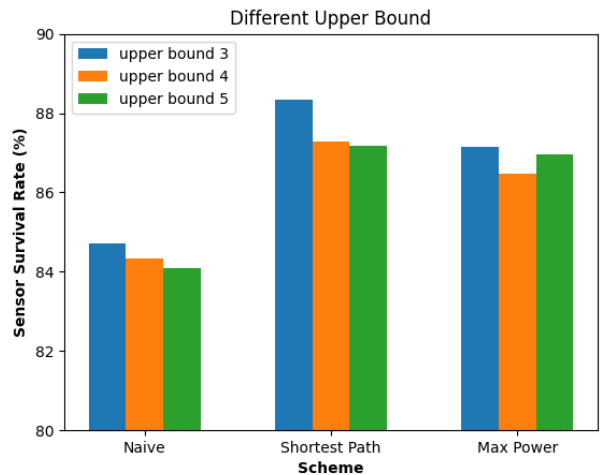
Figure 4. Impact of different upper bounds of the number of UAVs on the survival rate of sensors.